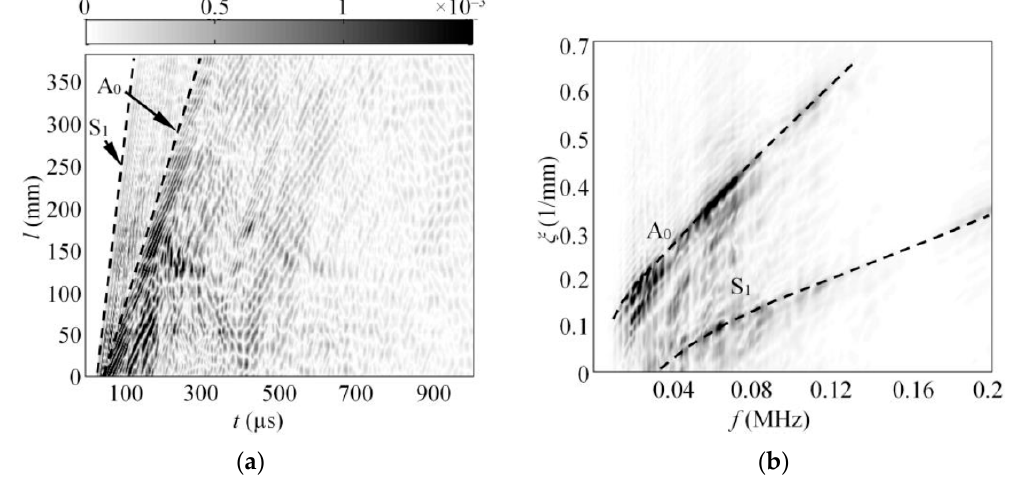
Figure 11. The experimental B-scan of the out-of-plane component of GW along the 4 mm thick GFRP sample ( a ), and the frequency-wavenumber representation of the B-scan data ( b ).